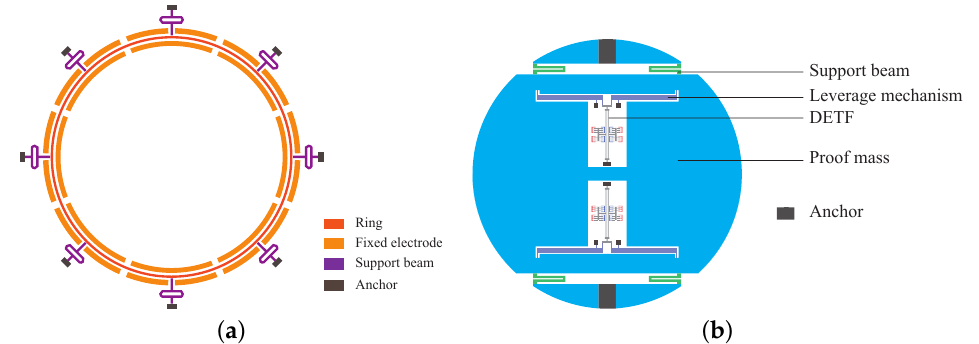
Figure 6. Schematic diagram of structural components. ( a ) The structure of the microring gyroscope. ( b ) The structure of the MEMS resonant accelerometer.